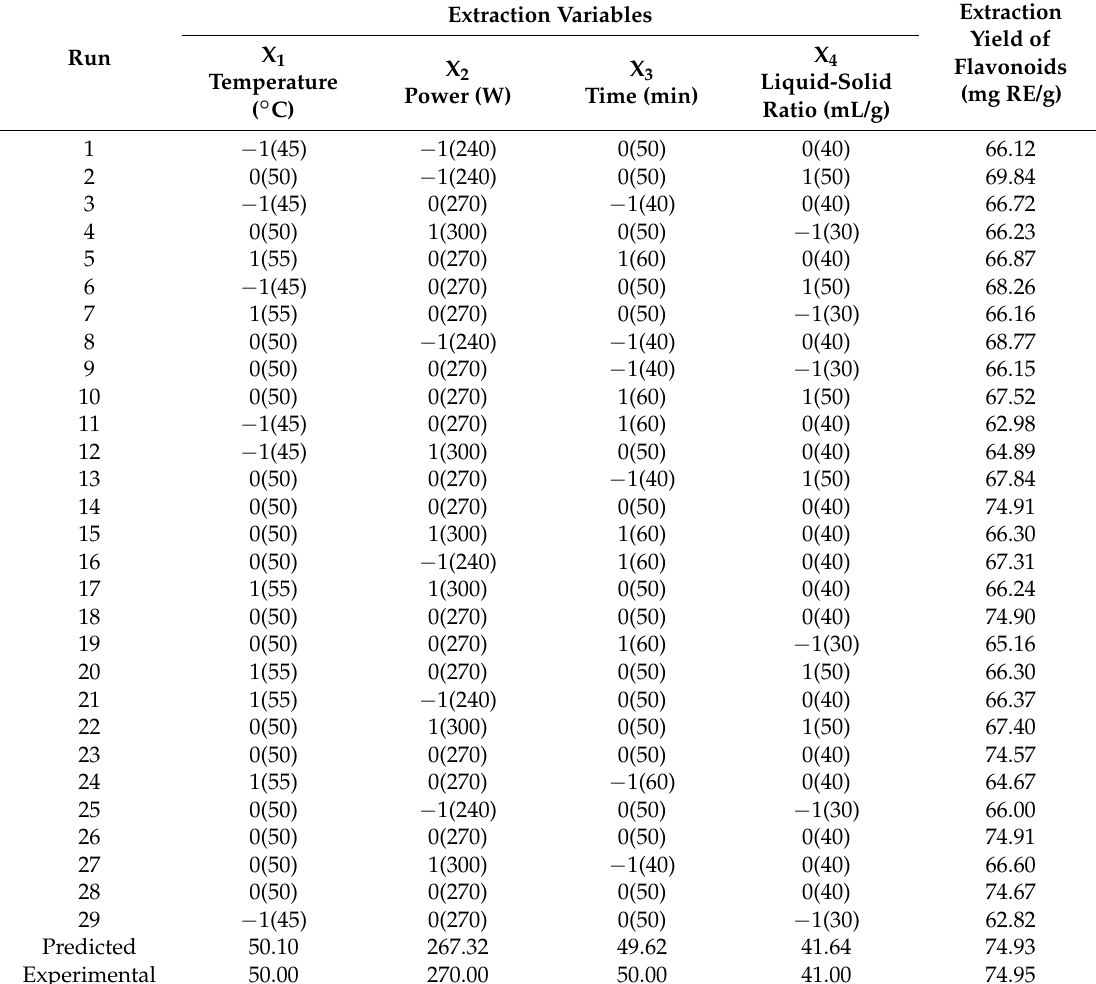
Table 1. BBD design with the experimental and predicted values for extraction